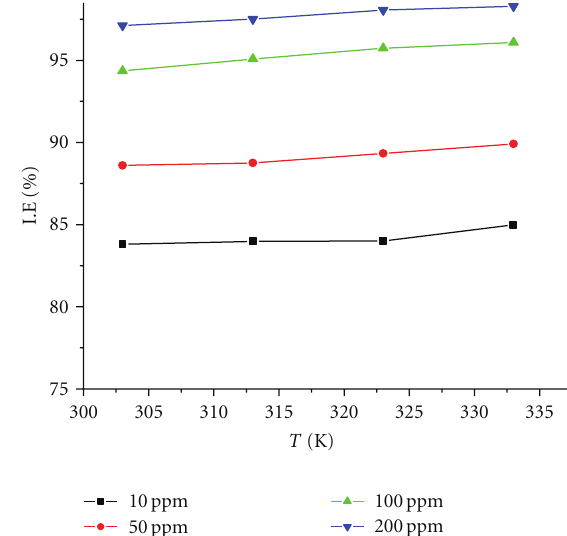
Figure 4: E ff ect of temperature on I.E (%) for mild steel in 1 M HCl in the presence of di ff erent concentrations of the inhibitor.